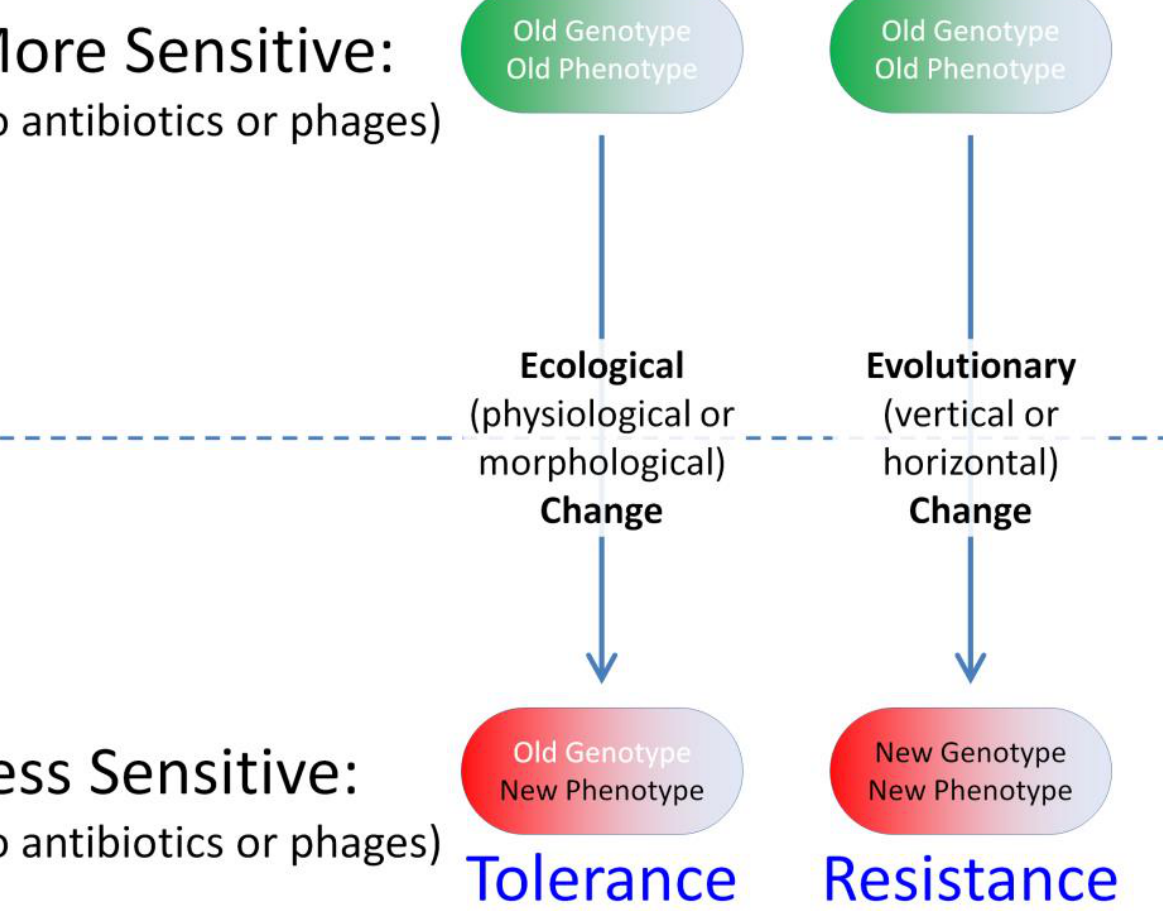
Figure 1. Ecological vs. evolutionary change in bacterial susceptibility to phages or antibiotics. Ecological processes involve interactions between organism phenotypes and their environments, whereas evolutionary processes involve changes in allele frequencies (organism genotypes) over time. Vertical evolutionary changes (parent to offspring) involve mutations, whereas horizontal evolutionary change (horizontal or lateral gene transfer) involves what is known as genetic migra- tion. The latter, though not emphasized here, involves the acquisition especially of evolved genetic material from other populations, e.g., such as in the course of acquisition of plasmids by bacteria. Tolerance-type phenotypes that result from near-term evolutionary changes are also not empha- sized here. “ Tolerance ” in the antibiotics literature also can be used to describe newly arising bacterial mutants that display reduced susceptibilities, except during MIC determina- tions. Such newly arising “ tolerance ” , however, is not what is being considered here; this